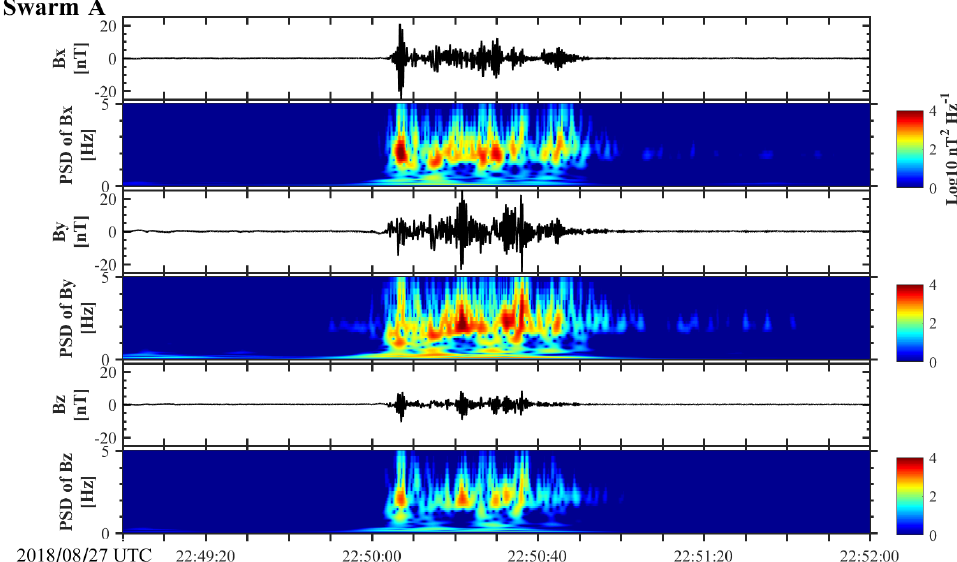
Figure 3. The power spectral densities (PSDs) of the magnetic fields in the local north-east-down (NED) coordinates during the Pc1 wave period (22:50–22:51UTC) observed by the Swarm-A